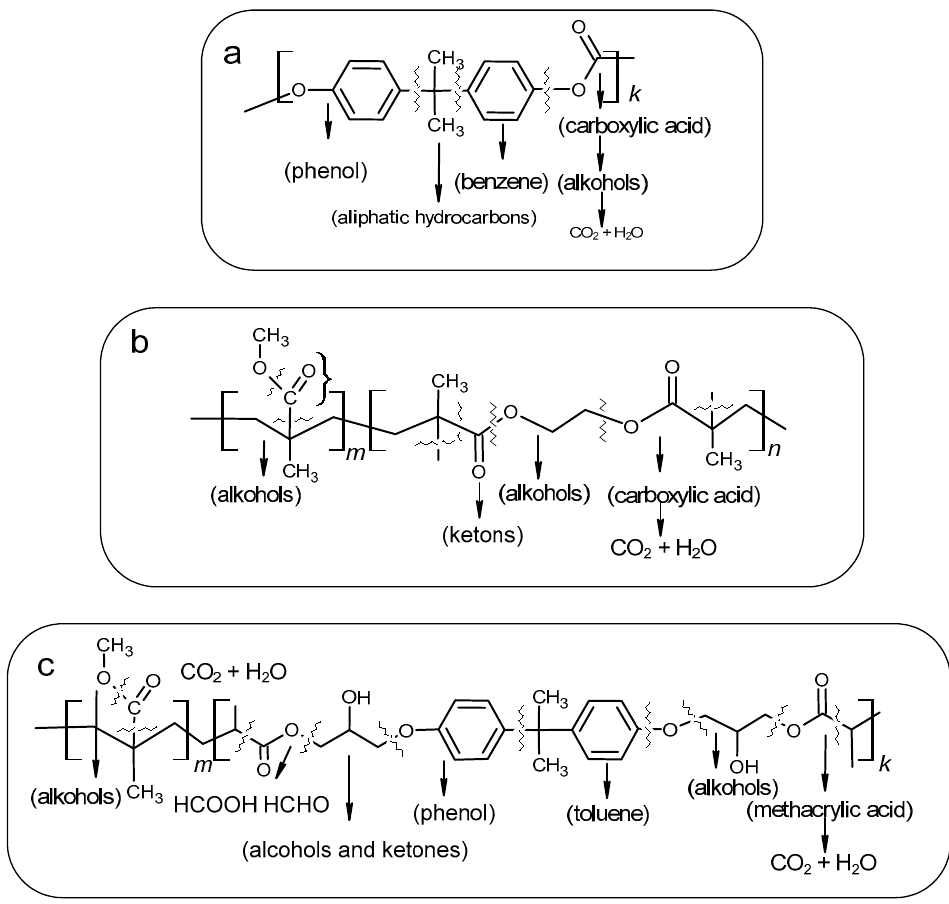
Figure 7. Proposed mechanisms of polymer fragmentation under heating: ( a ) polycarbonate, ( b ) EGDMA-MMA copolymers, ( c ) BPA.GDA-MMA copolymers.